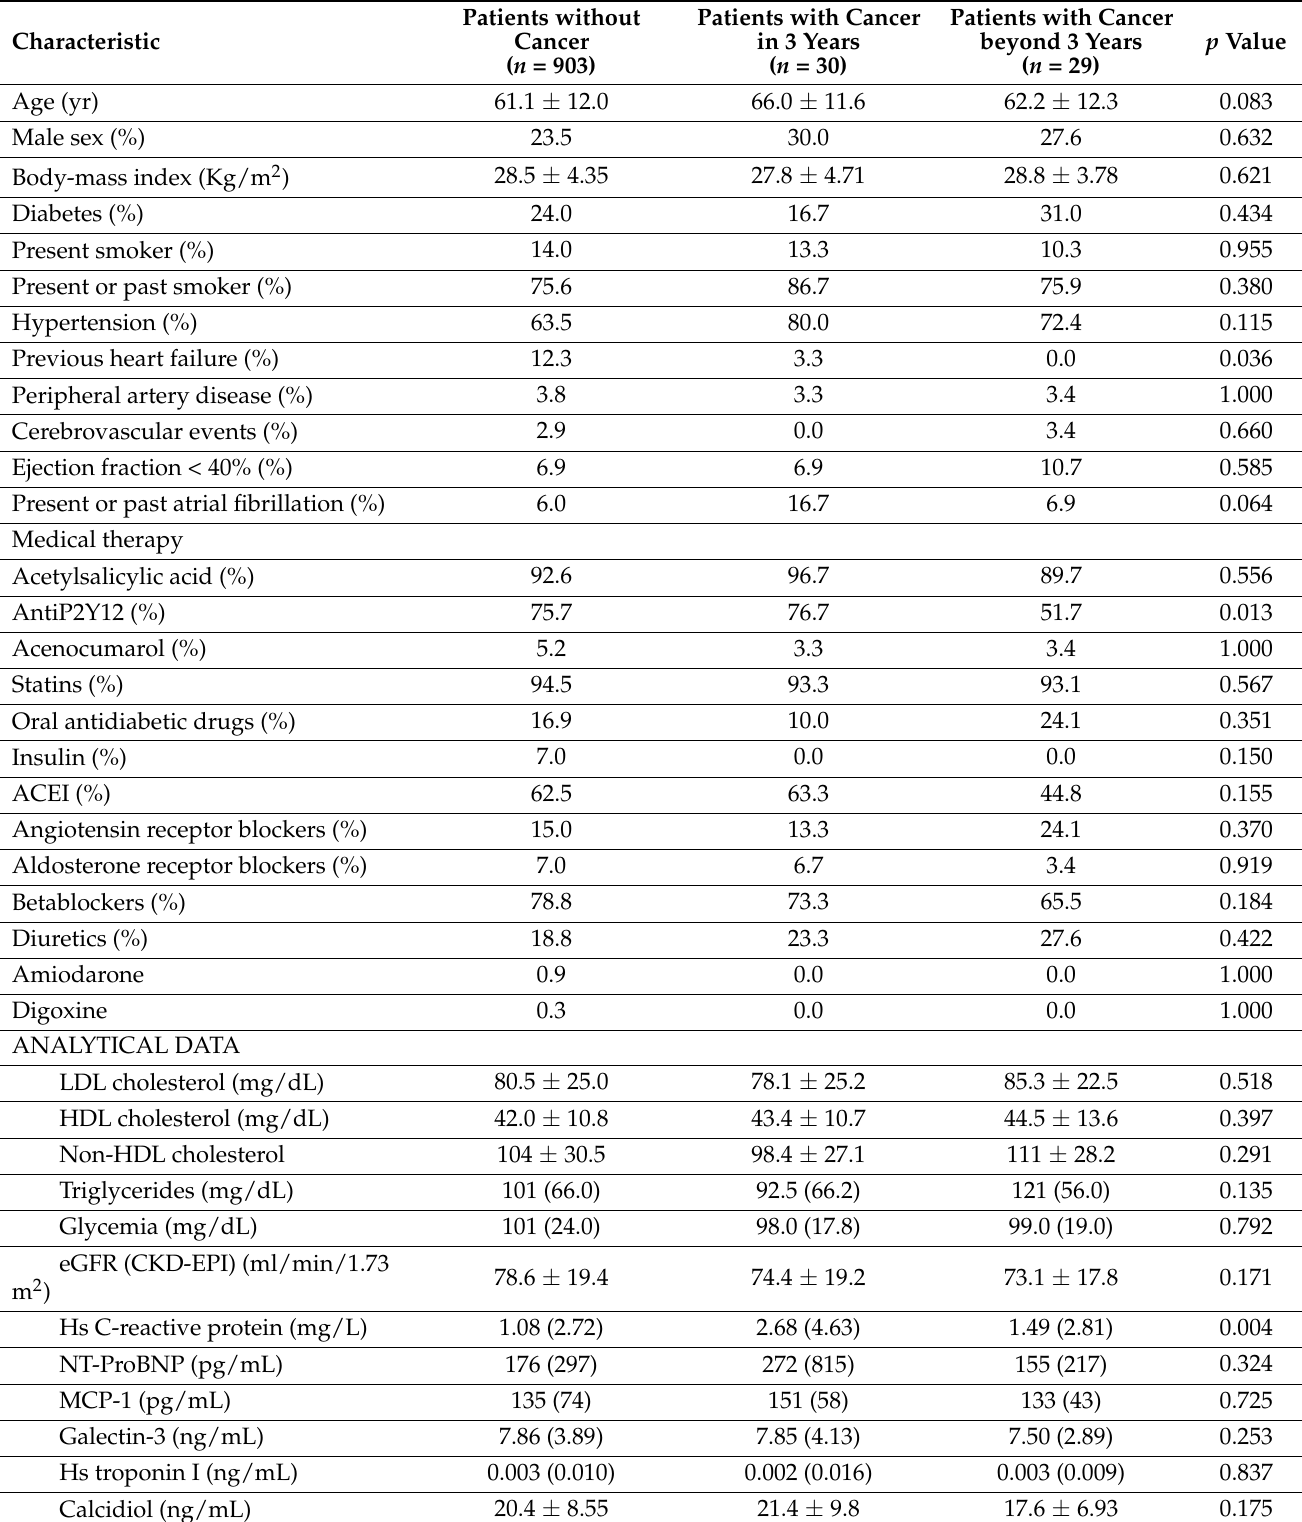
Table 1. Baseline characteristics of the